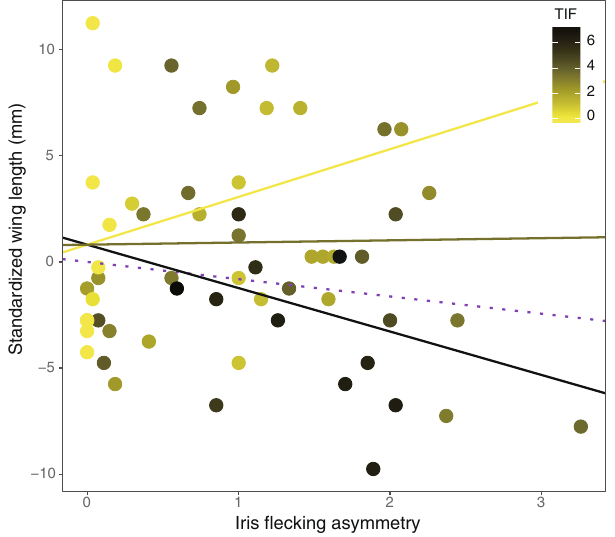
Figure 5. A figure illustrating the interaction effect between total iris flecking and iris flecking asymmetry on wing length in male common cuckoos. The grey line represents the expected slope (0.1) for individuals with mean iris flecking (2.50) while the yellow (slope = 2.25) and black (slope = − 2.05) lines indicate the fitted line for individuals with clearer (mean iris flecking - one standard deviation, 0.68) and darker (mean iris flecking + one standard deviation, 4.32) iris. The dotted purple line (slope = − 0.81) represents the fitted line for the univariate relationship between iris flecking asymmetry and wing length. Each dot represents each individual and the color was graded according to the total amount of iris flecking